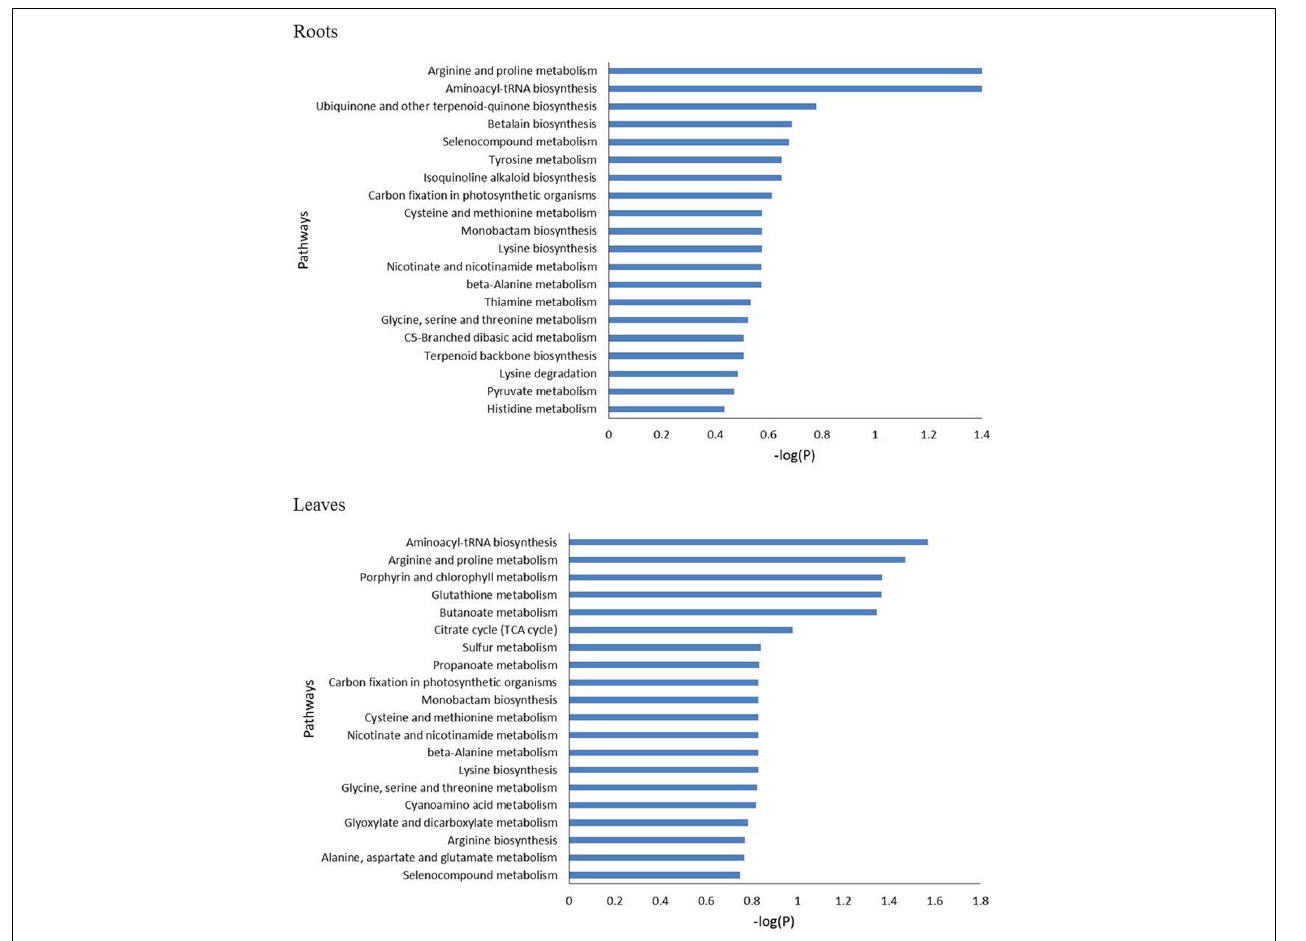
FIGURE 9 | The top 20 enriched pathway analysis of significant differential accumulated metabolites in roots and leaves of Puccinellia nuttalliana between 0 mM and 150 mM NaCl treatments.